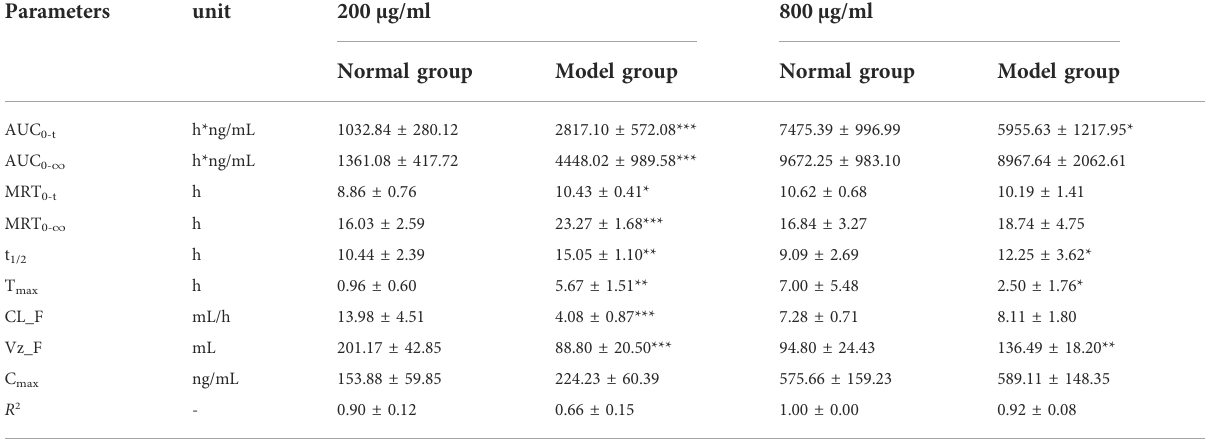
TABLE 6 The pharmacokinetic parameters of 4,5-dicaffeoylquinic acid in RAW264.7 cells after treatment with 200 μ g/ml and 800 μ g/ml of I. cappa extracts ( (cid:1) x ± SD, n = 6).